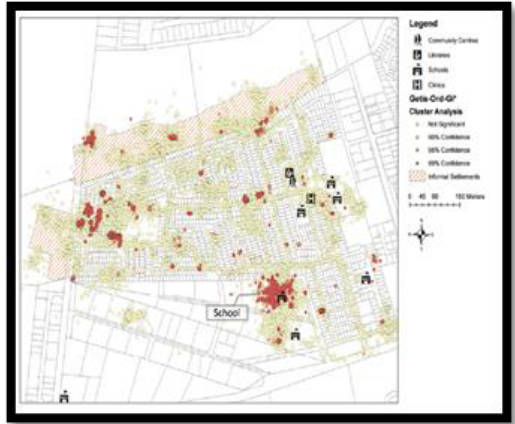
Figure 4 . Hotspot Analysis of TB (Patterson et al., 2017)